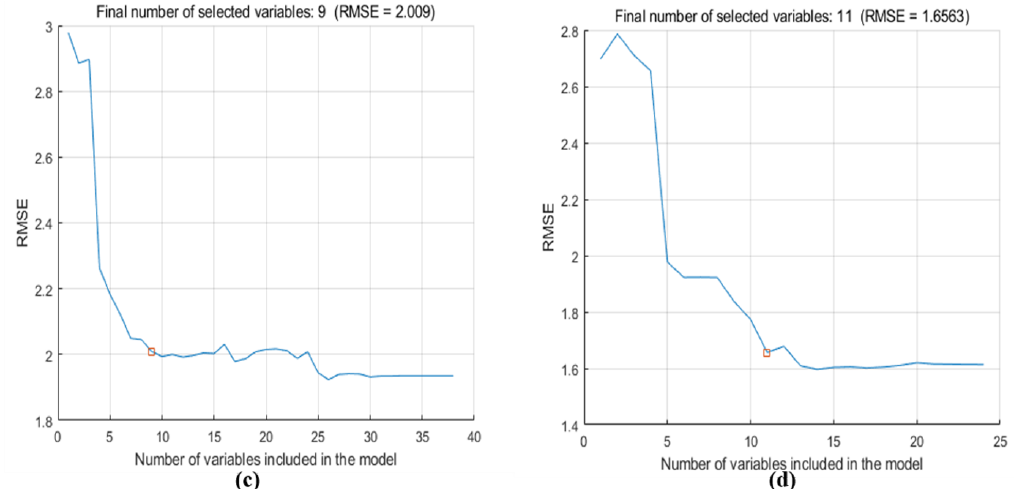
Figure 3. SPA screening results: ( a ) OR-SPA, ( b ) SG-FDR-SPA, ( c ) SG-SDR-SPA, and ( d ) SNV-SPA.